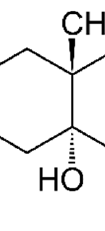
Figure 15. Chemical structure of geosmin.